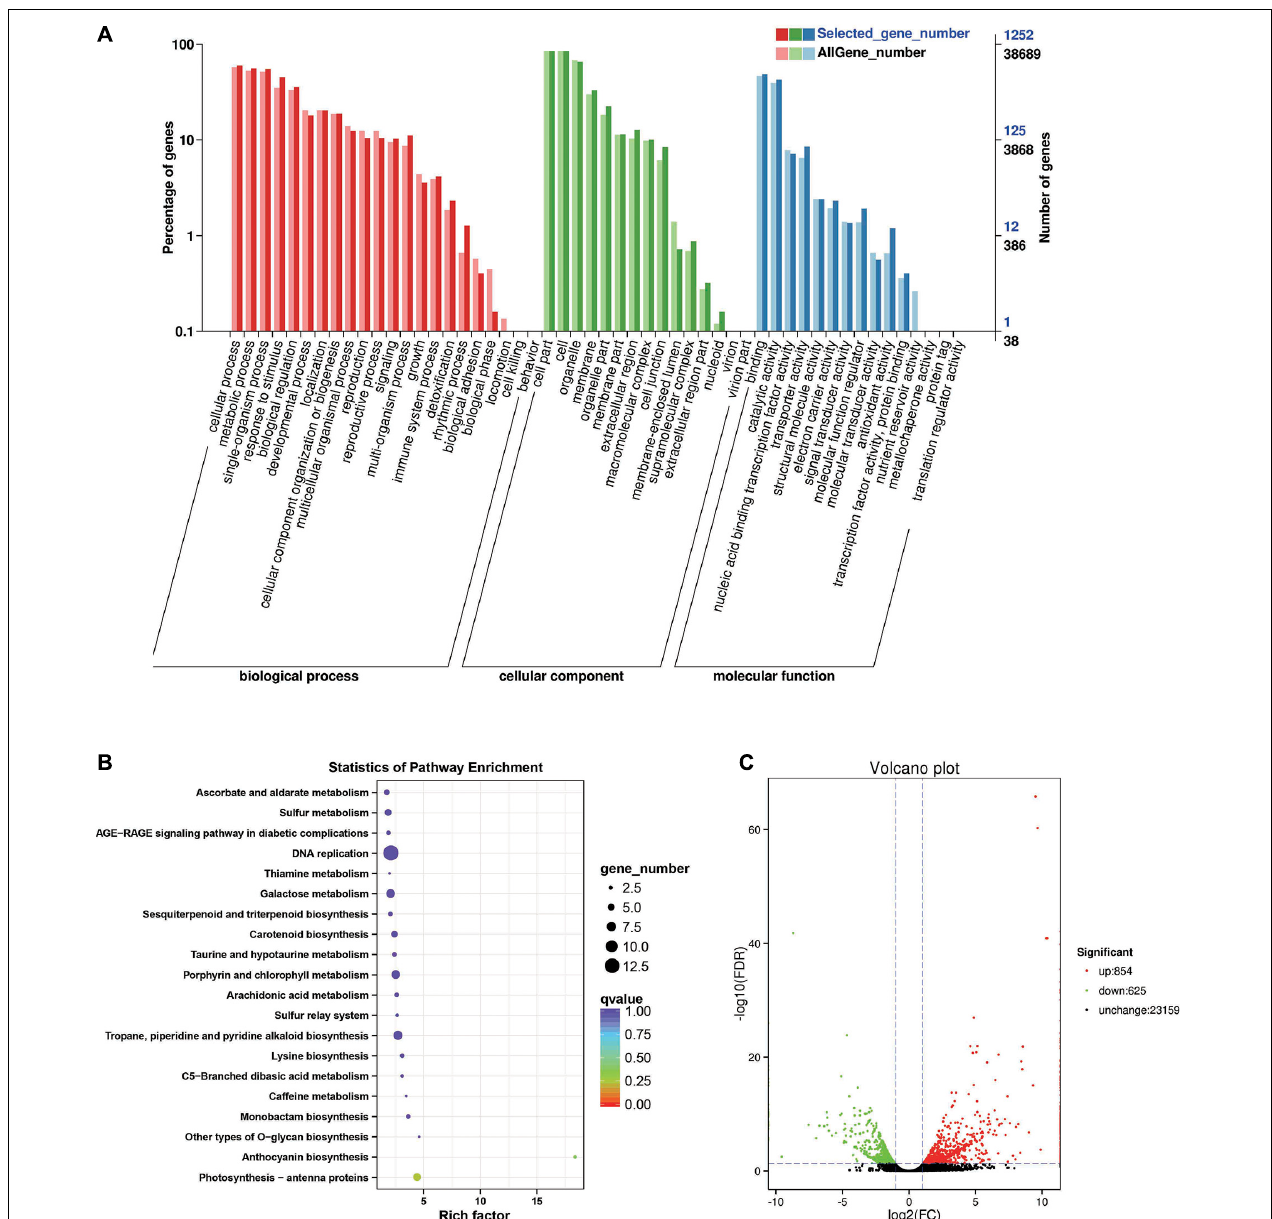
FIGURE 6 | Enrichment analysis of differentially expressed genes between C4 and C2 groups. (A) GO classification statistics of differentially expressed genes. It mainly includes three branches: biological process, cellular component, and molecular function. (B) KEGG pathway enrichment statistics of differentially expressed genes. (C) Volcano plot statistics of the number of differentially expressed genes. C2: BcL.1-4 , C4: BcL.2-4